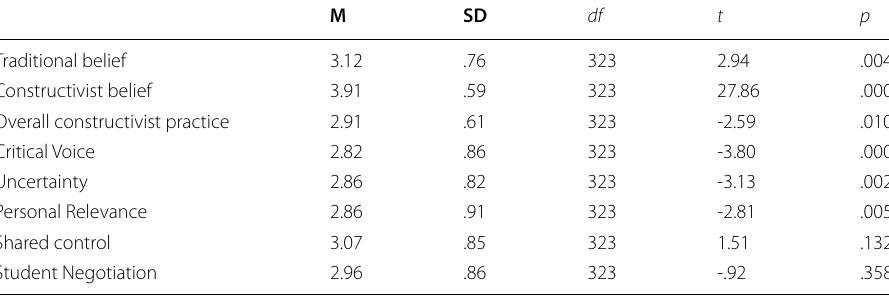
Standard deviation, df =